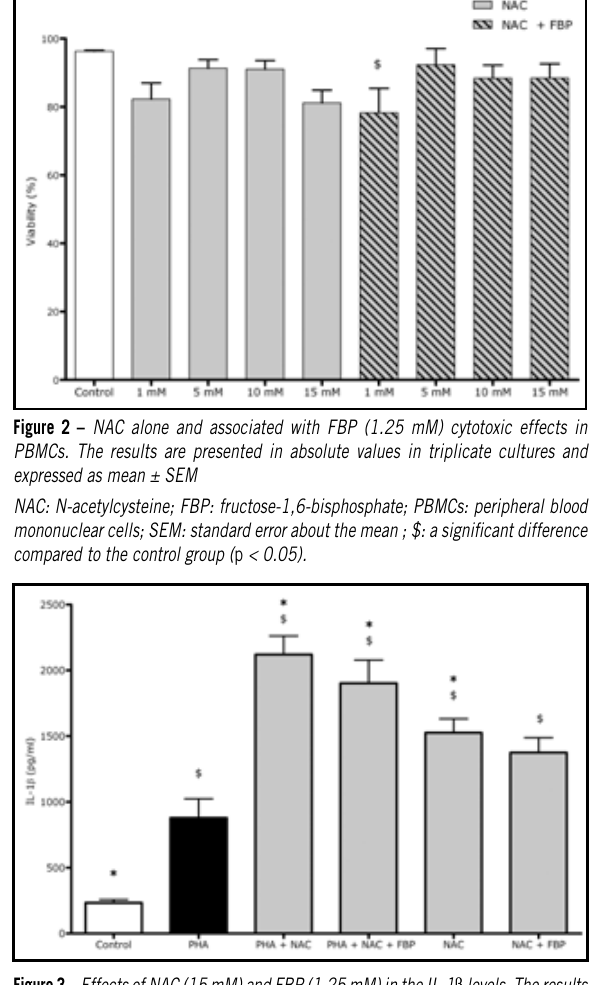
Figure 3 – Effects of NAC (15 mM) and FBP (1.25 mM) in the IL-1 β levels. The results are presented in absolute values in triplicate cultures and expressed as mean ± SEM